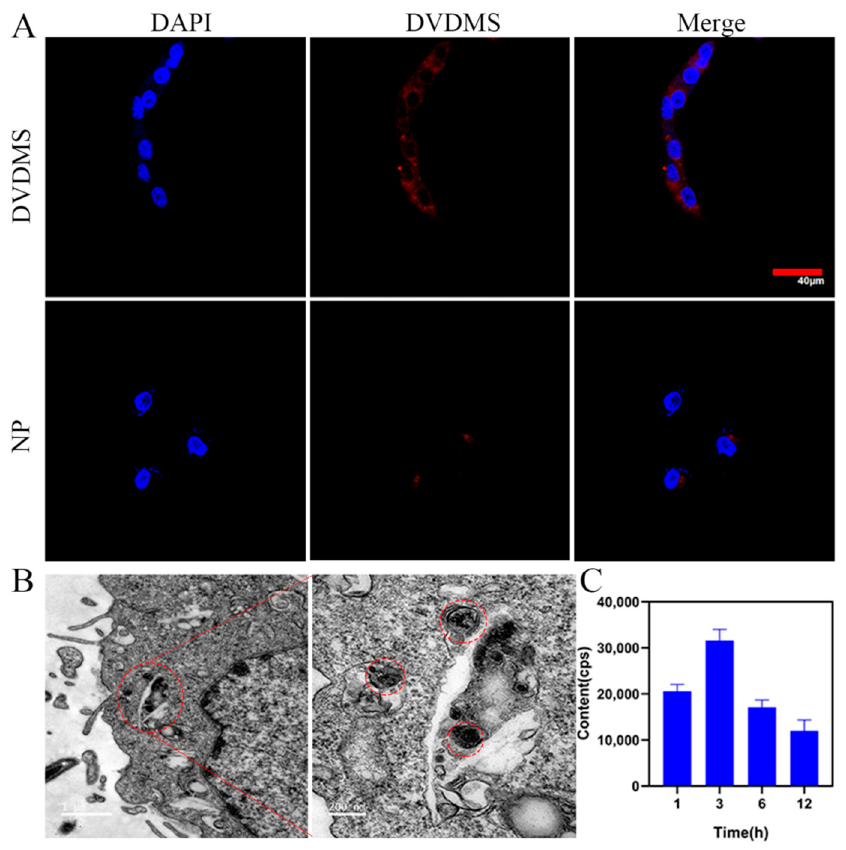
Figure 2. ( A ) CLSM images of 4T1 cells incubated with DVDMS or Cu/DVDMS (DVDMS concen- tration was 10 µ g/mL) at 12 h. Scale bar = 40 µ m. ( B ) Cell TEM images of the cells incubated with Cu/DVDMS at 12 h. ( C ) Copper ion content of 4T1 cells incubated with Cu/DVDMS by ICP-MS at 1, 3, 6, 12 h ( n = 3, mean ±